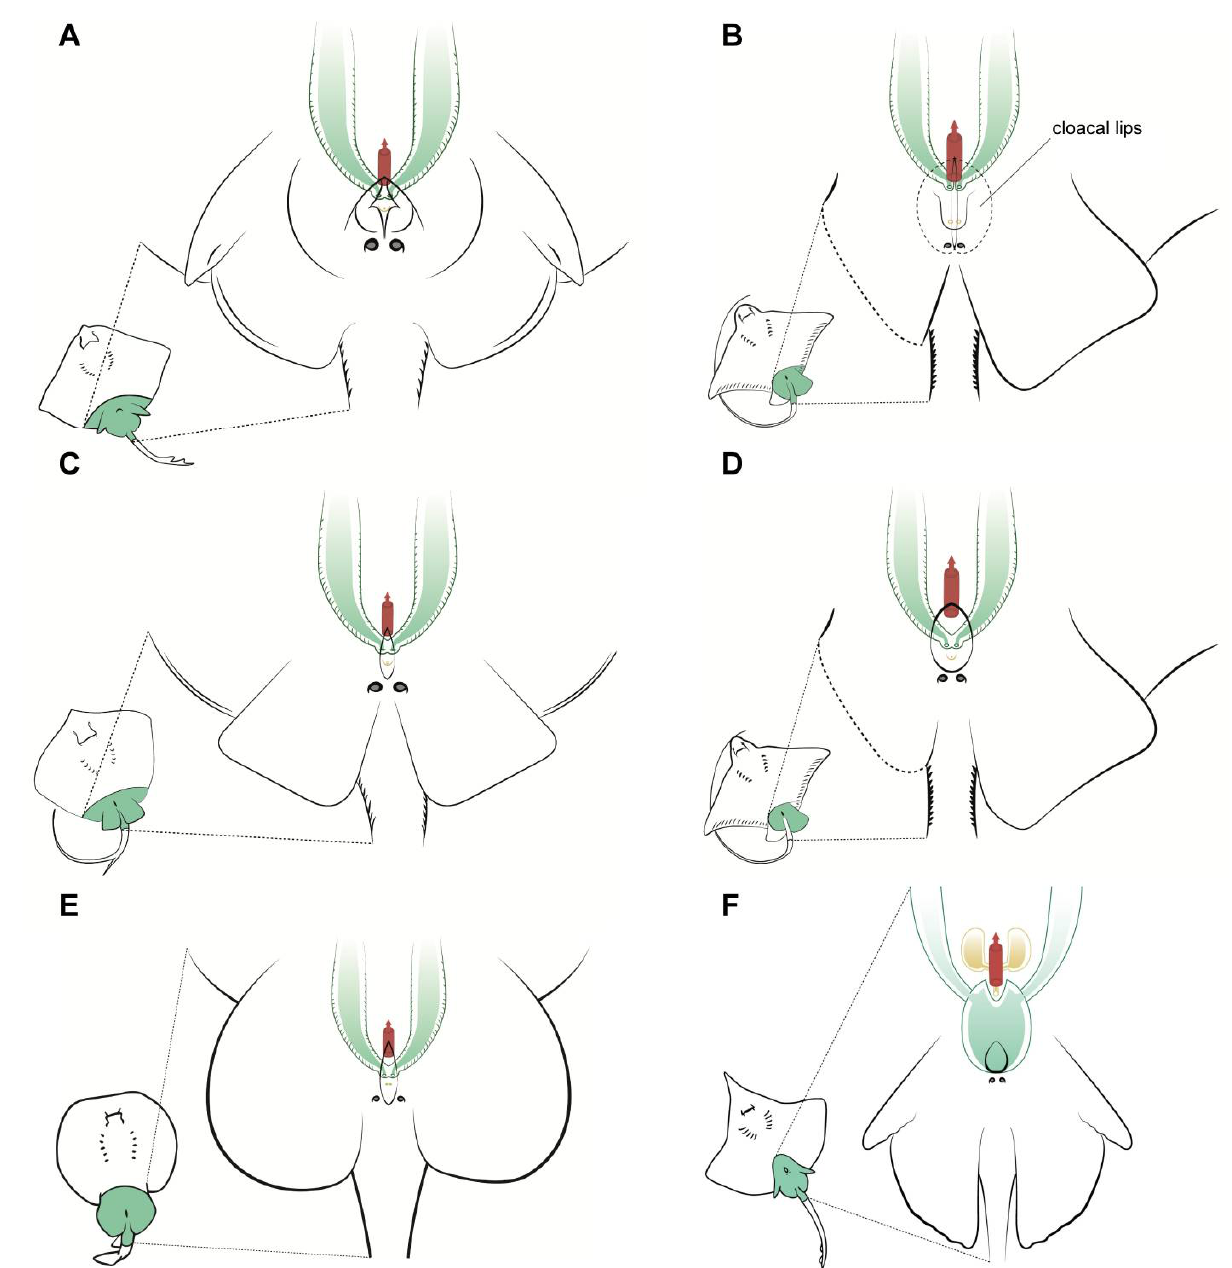
Figure 4. Specific female anatomy. Species-specific morphologies in female batoids that could be relevant when performing artificial insemination. Reproductive, excretory, and digestive systems are marked with different colours. Green: the uteri; yellow: the excretory system; red: access to the digestive system. The grey circles are the abdominal pores that communicate the pleuroperitoneal cavity with the exterior. ( A ) model for skates, genus Raja ; ( B ) common eagle ray Myliobatis Aquila ; ( C ) model observed in common stingray Dasyatis pastinaca ; ( D ) bull ray Aetomylaeus bovinus ; ( E ) marbled electric ray Torpedo marmorata ; ( F ) longnosed skate Dipturus oxyrinchus .